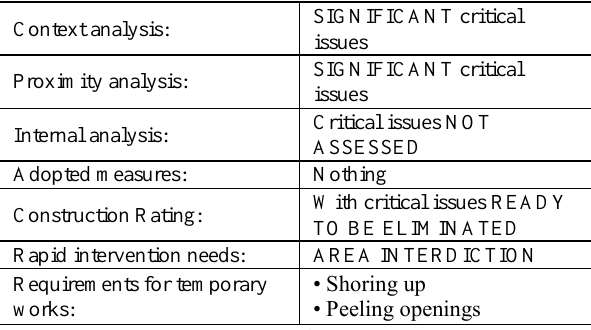
Figure 15. Synthesis of TriageEdEm